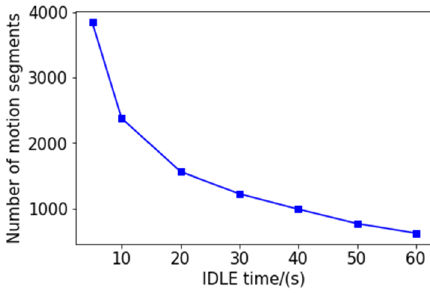
Figure 5. The relationship between the number of segments and the duration of continuous idle speed.